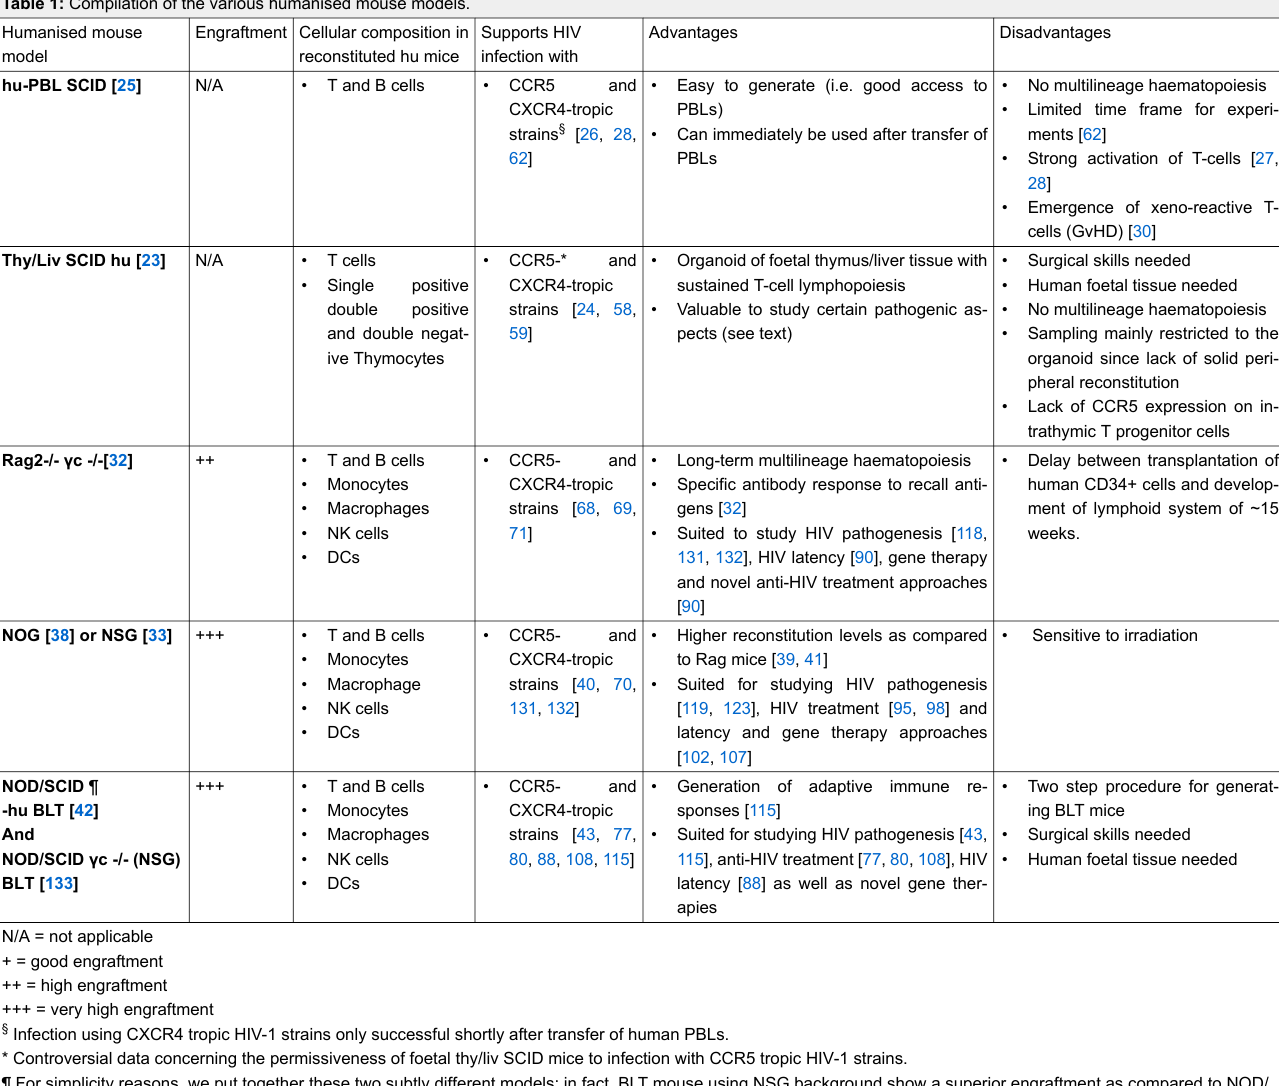
Table 1: Compilation of the various humanised mouse models. Humanised mouse